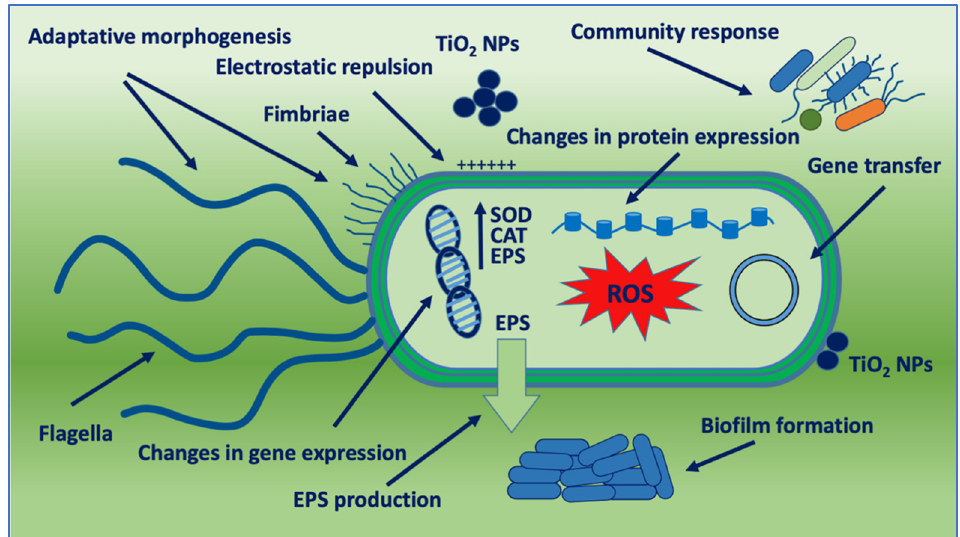
Figure 4. Schematic representation of bacterial adaptation mechanisms against TiO 2 NPs. SOD: SuperOxide Dismutase; CAT: Catalase; and EPS: Extracellular Polymeric Substance.